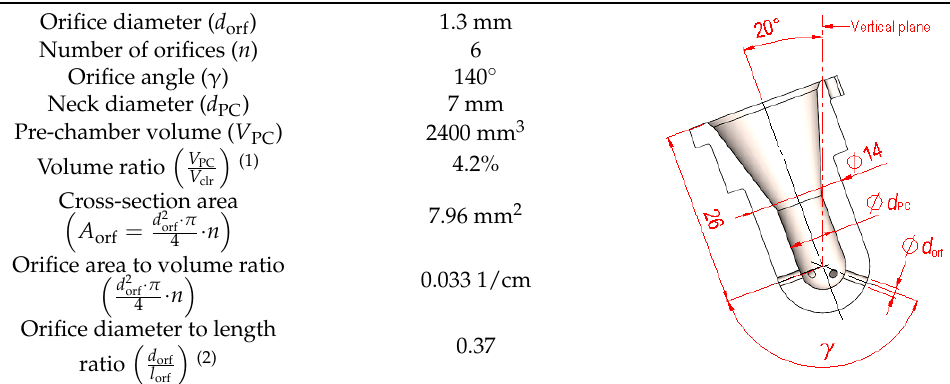
Table 2. Specification of the initial pre-chamber geometry.